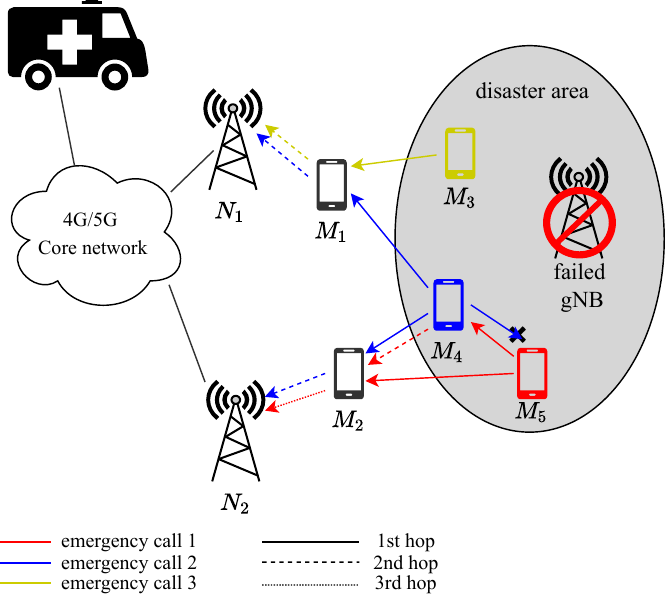
Figure 3. The proposed emergency call service architecture. Emergency UEs in the disaster area forward their calls in the direction of the functioning gNBs via relay UEs in the neighborhood. Distinct emergency calls generated by each emergency UE are represented by the color of the arrow. Solid lines indicate the D2D communication mode, while dashed lines indicate the classical communication between gNB and